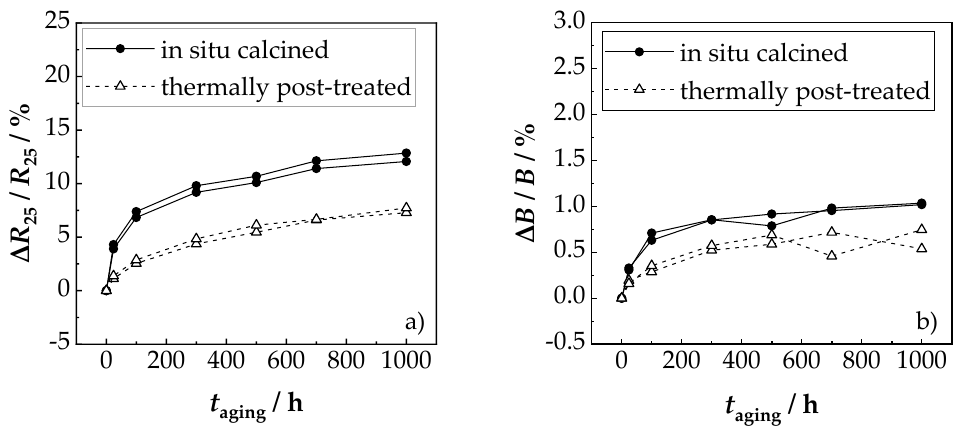
Figure 9. Aging-related change of ( a ) R 25 value and ( b ) B value for chip-based components after 1000 h at 125 °C.